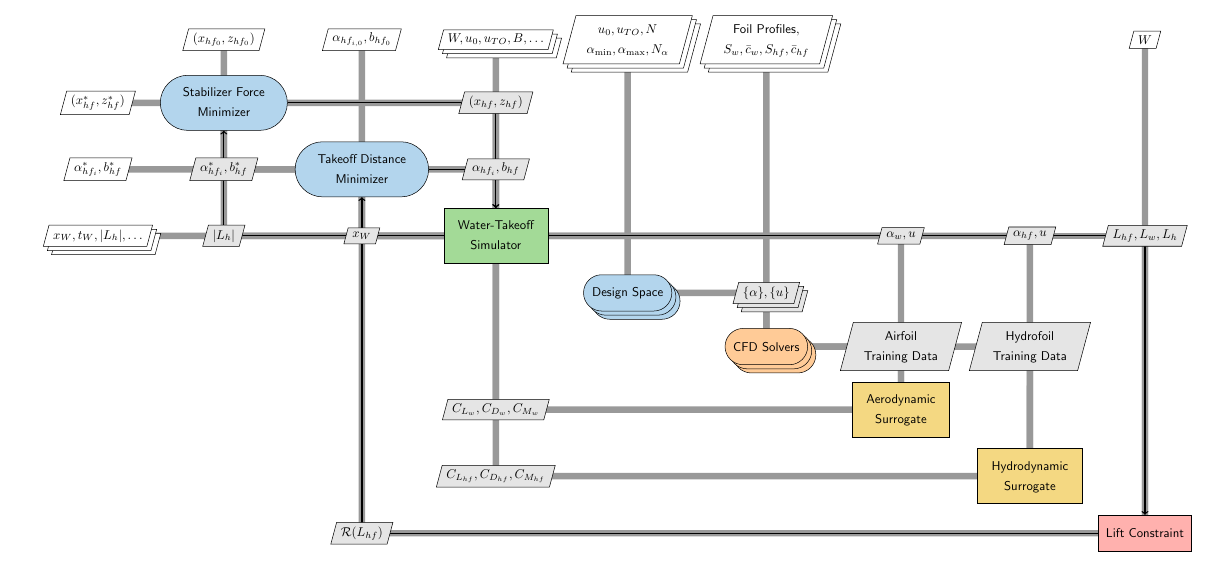
Figure 5. XDSM diagram for the hydrofoil design